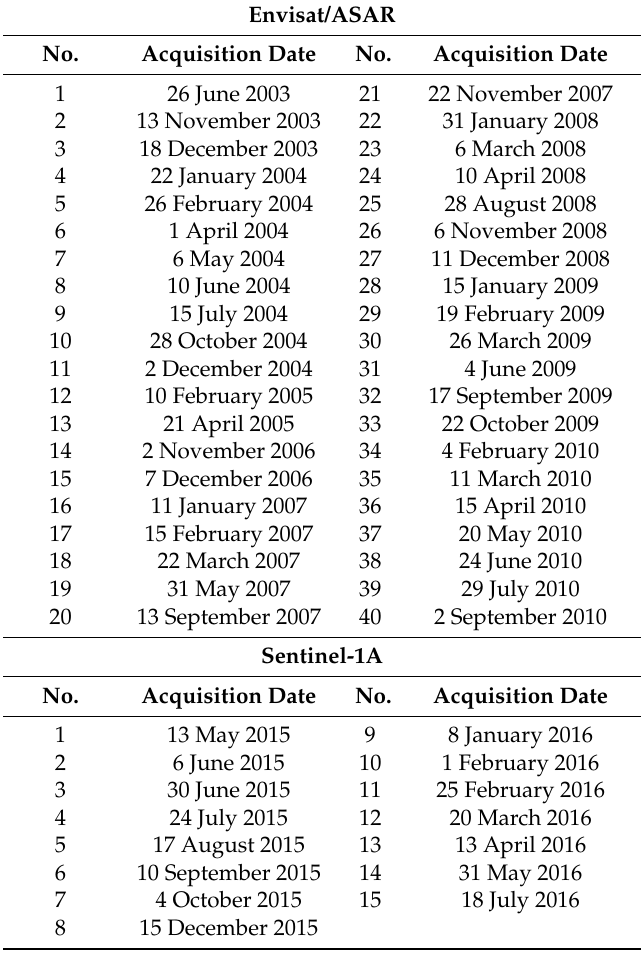
Table 1. Envisat and Sentinel data for Lanzhou New